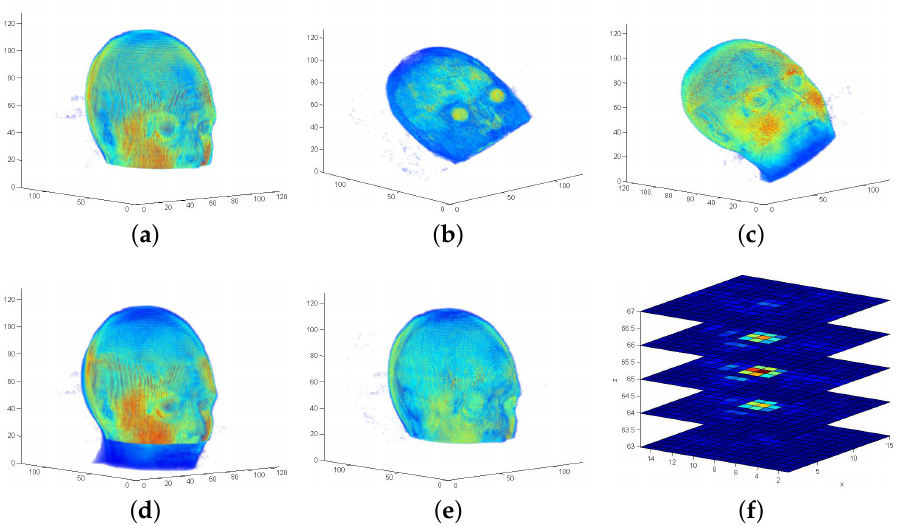
Figure 16. Example for FMS registration. The scans (weighting functions T1, T2, MPRAGE) are taken from the RIRE-repository, patient108 . The scans are interpolated on a grid N VS = 128 according to the provided pixel size and slice thickness. ( f ): A FMS registration peak (using all frequency layers). Compared to the LF-FMS, the result shows a sharp peak at one voxel position. ( a ) MRT scan (T1). Standard position rendered in the center of a grid N VS = 128. ( b ) MRT scan (T2). Yaw, roll, pitch rotated up to 30 ◦ . ( c ) MRT scan (MPRAGE). Yaw, roll, pitch rotated up to 30 ◦ . ( d ) Resulting alignment of scan (T1) and scan (MPRAGE). ( e ) Resulting alignment of scan (T1) and scan (T2). ( f ) Example FMS registration peak—scan pair (T1,T2).